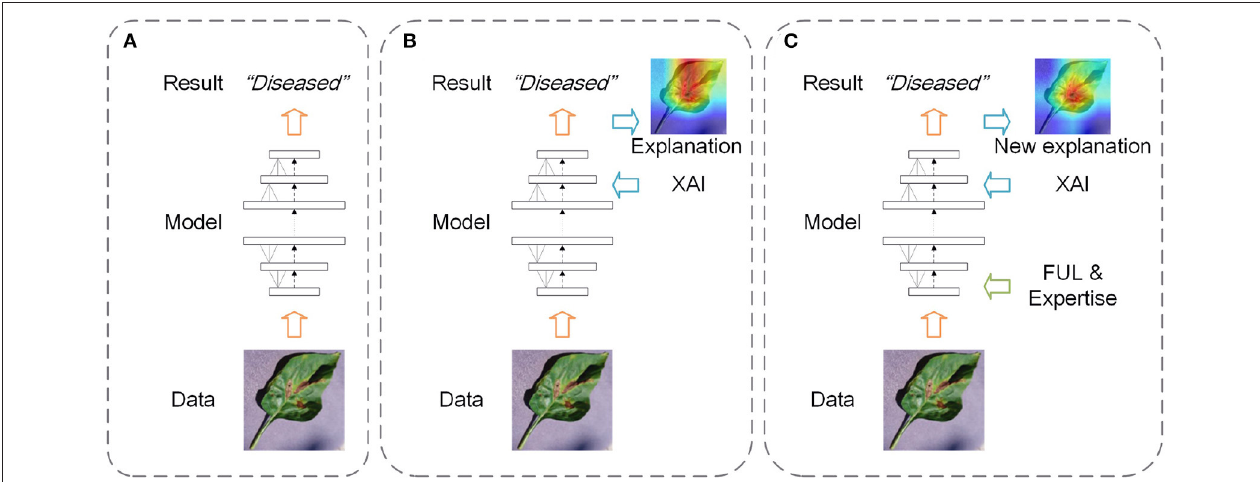
FIGURE 1 | Three frameworks of deep learning studies ( A : get the results only; B : get the results and explanations; C : improve the model based on explanations and expertise).